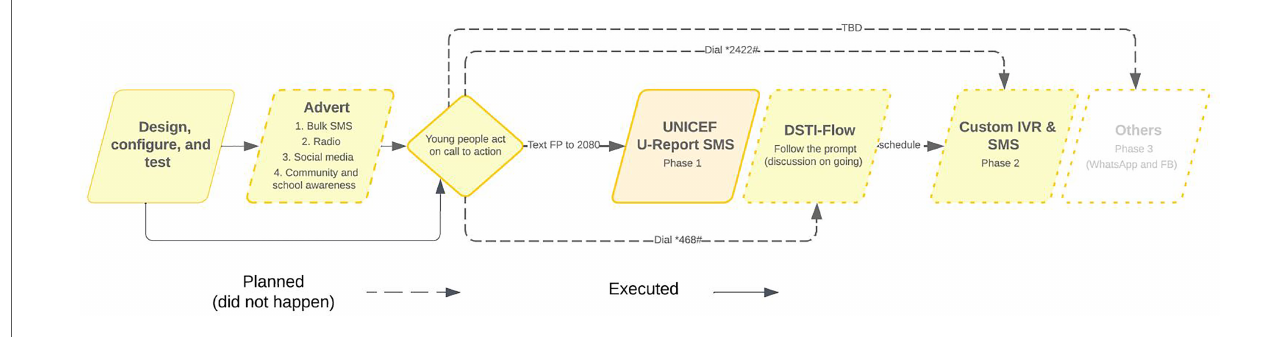
FIGURE 3 Conceptual strategy for working with collaborating